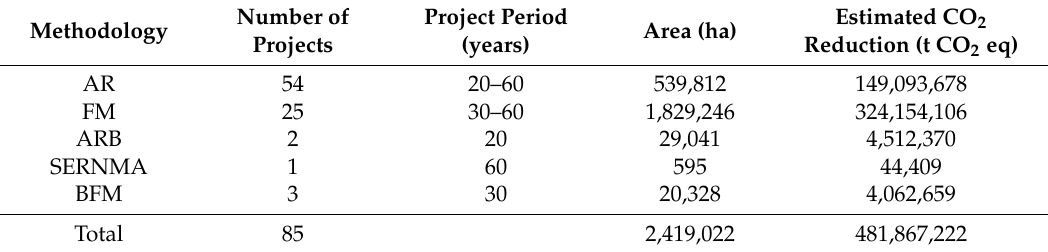
Table 3. Validated projects registered on the China Certified Emission Reduction Exchange info-platform [34]. Number Methodology